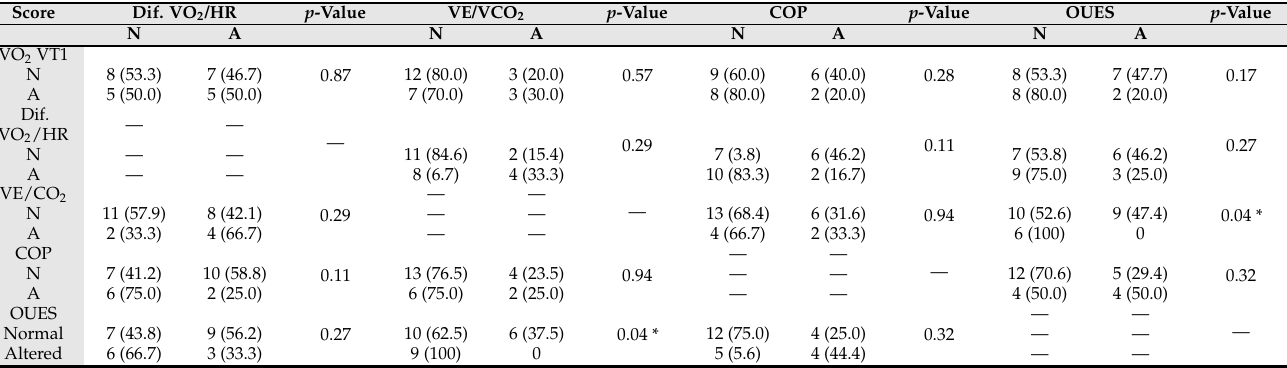
Table 4. Normal (N) and altered (A) categorical scores, comparison between variables per Chi square. The numbers represent the condition (N or A), the number of subjects in this condition as the first number, followed by the percentage in parentheses, p value and * significant